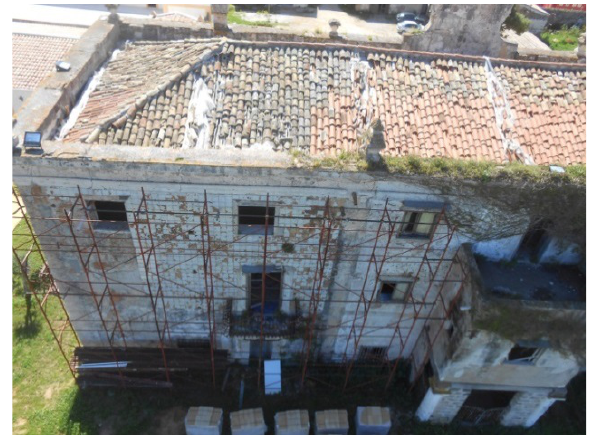
Figure 6. Oblique image from RPAS.